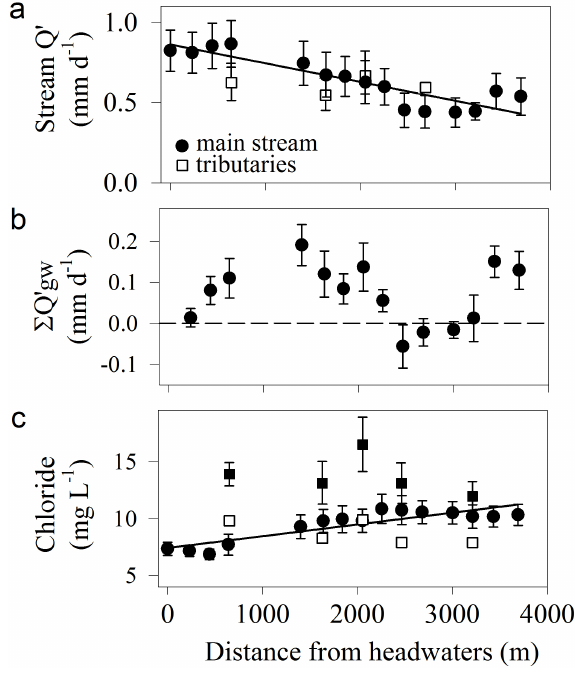
Figure 4. Longitudinal pattern of (a) area-specific stream discharge, (b) cumulative area-specific net groundwater inputs along the reach, and (c) stream chloride concentration. Symbols are average and standard error (whiskers) for the main stream (circles) and trib- utaries (squares). Stream chloride concentration in tributaries is shown separately for the dormant (white) and vegetative (black) pe- riod. Tributaries showed no differences in discharge between the two periods. Model regressions are indicated with a solid line only when significant (tributaries not included in the